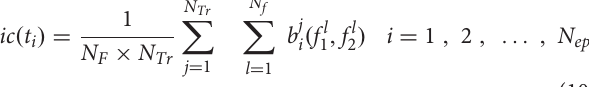
time window was at least 590 ms after the stimulus onset.